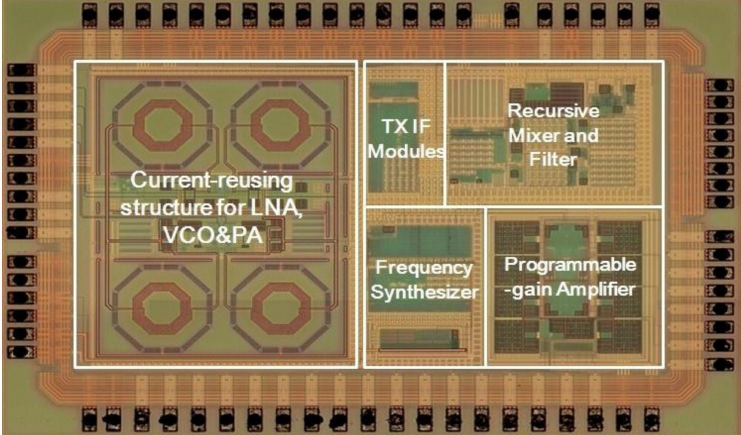
Figure 9. The microphotograph of the proposed